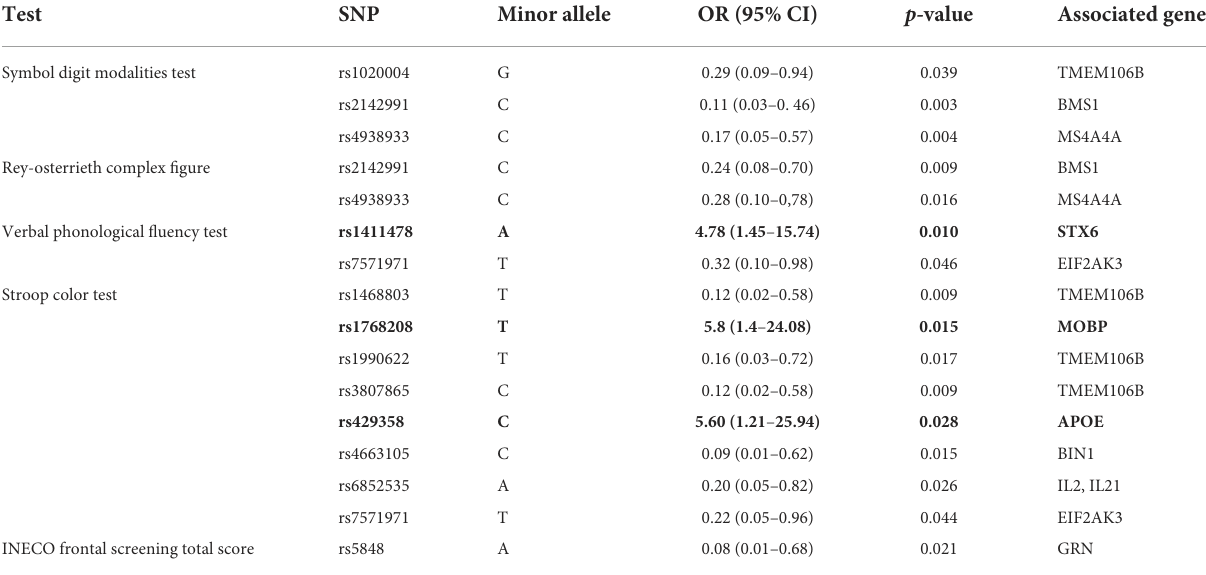
TABLE 3 OR values for SNPs with significant associations with neuropsychological test